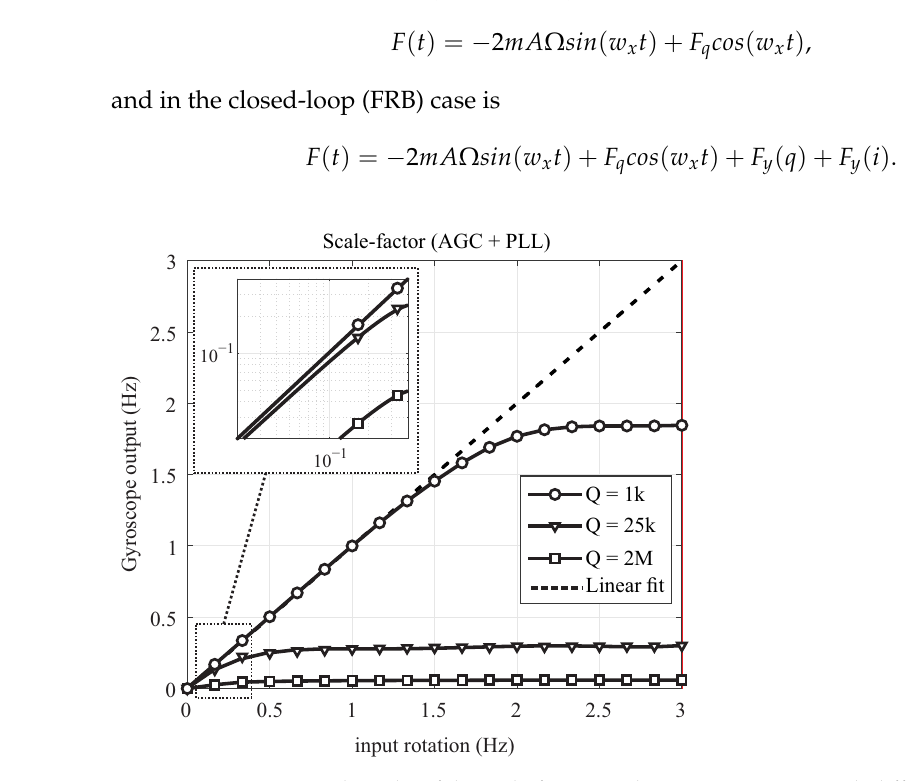
Figure 17. Experimental results of the scale-factor nonlinearity in sensors with different Q-factors and mode-matched condition, operating in the open-loop rate mode (PLL and AGC loops are enabled).